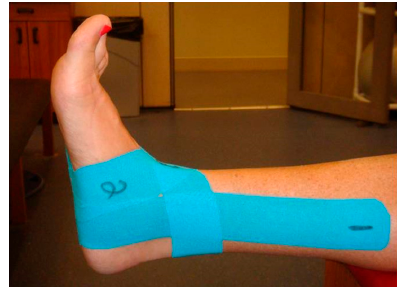
Figure 3. Medial view of the second strip of Kinesio tape.